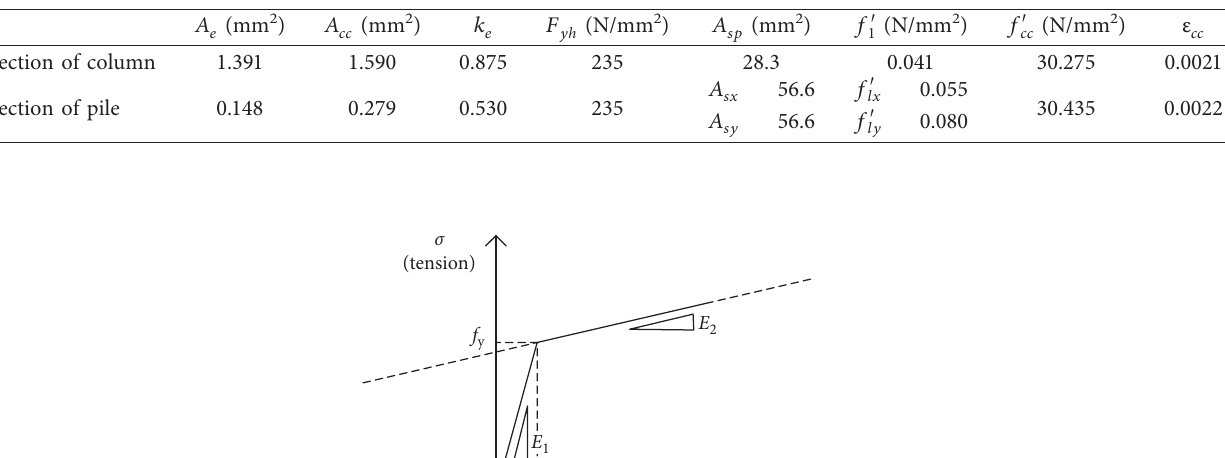
Table 14: Parameters related to confined concrete strength.